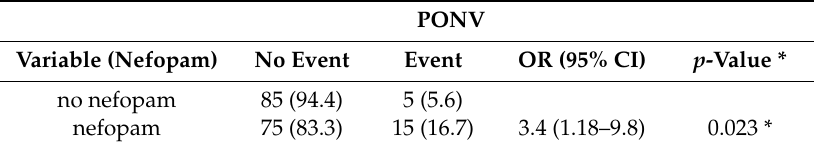
Table 8. Association between PONV and nefopam.